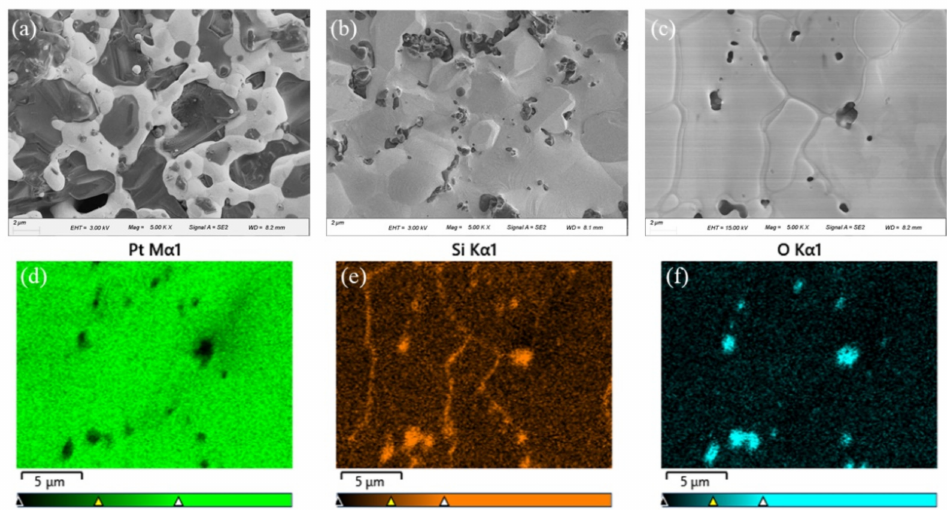
Figure 9. Scanning electron microscopy images of the Pt electric heating films. ( a ) The pristine film, ( b ) before the current jump, and ( c ) after the current jump. ( d – f ) Energy dispersion X-ray spectroscopy mapping of the Pt, silicon, and oxygen elements of the Pt electric heating film after the current